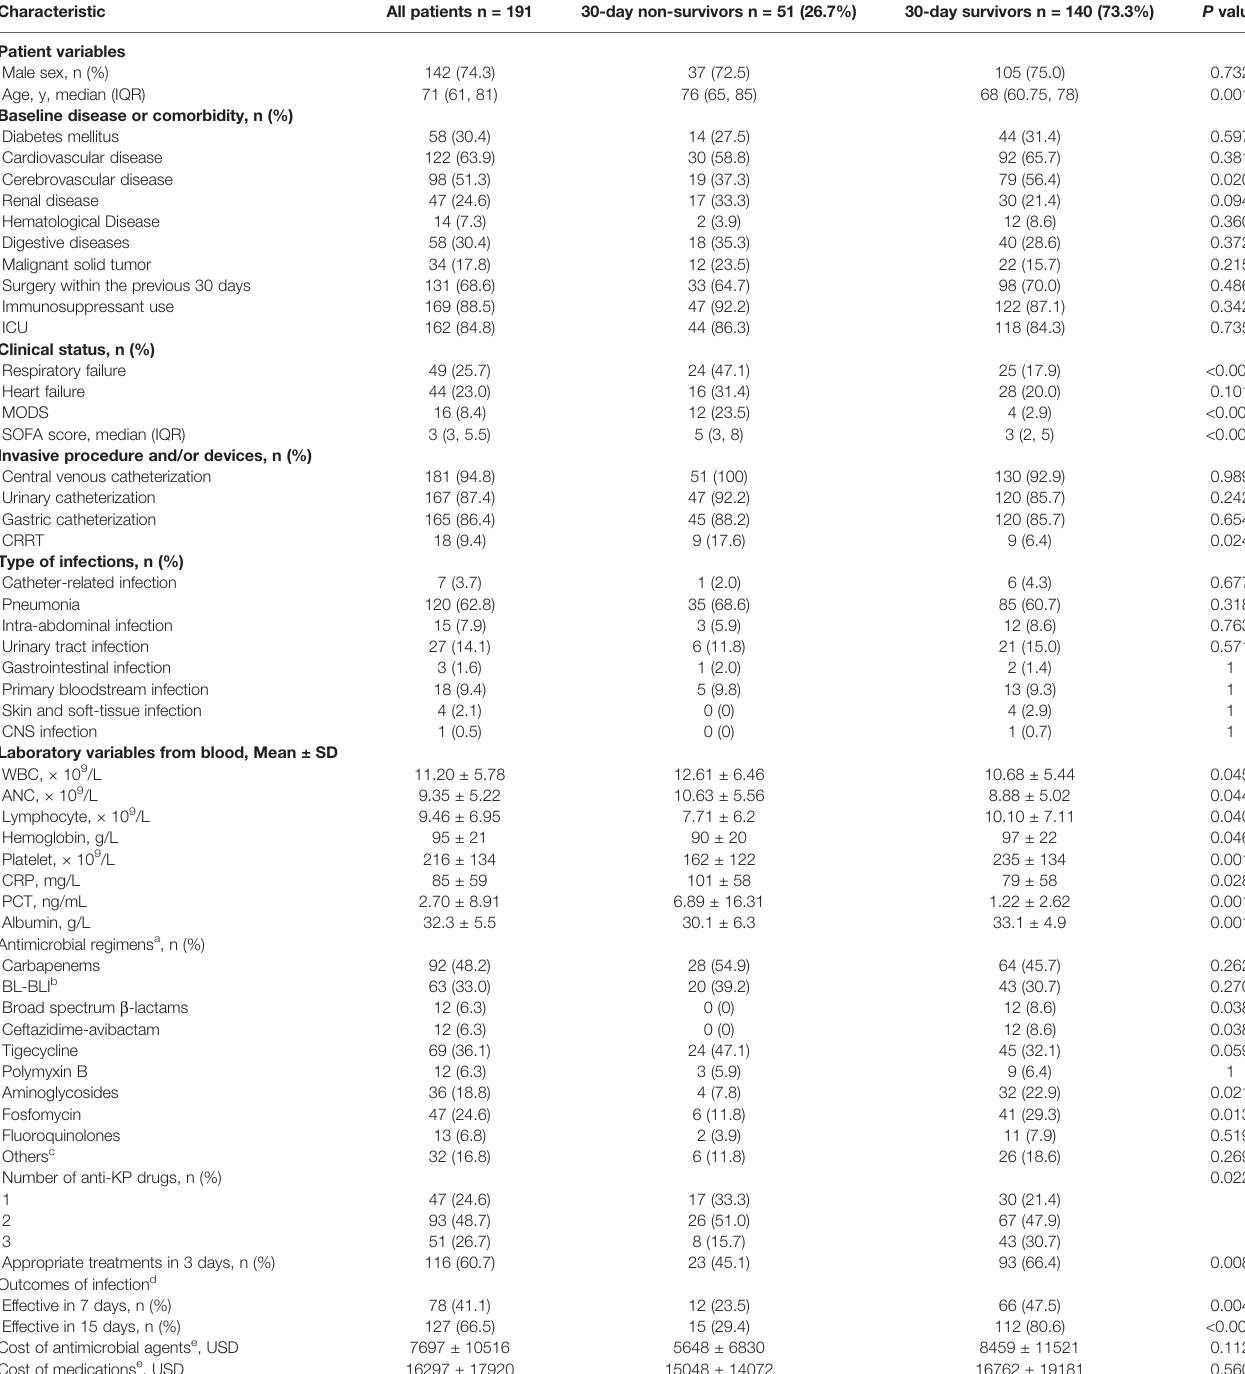
TABLE 1 | Characteristics of patients with carbapenem-resistant Klebsiella pneumoniae infections.